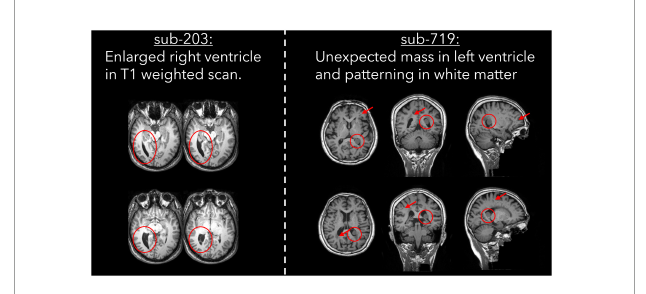
FIGURE5 T1 weighted images for two cases of atypical brain structure that were present in the